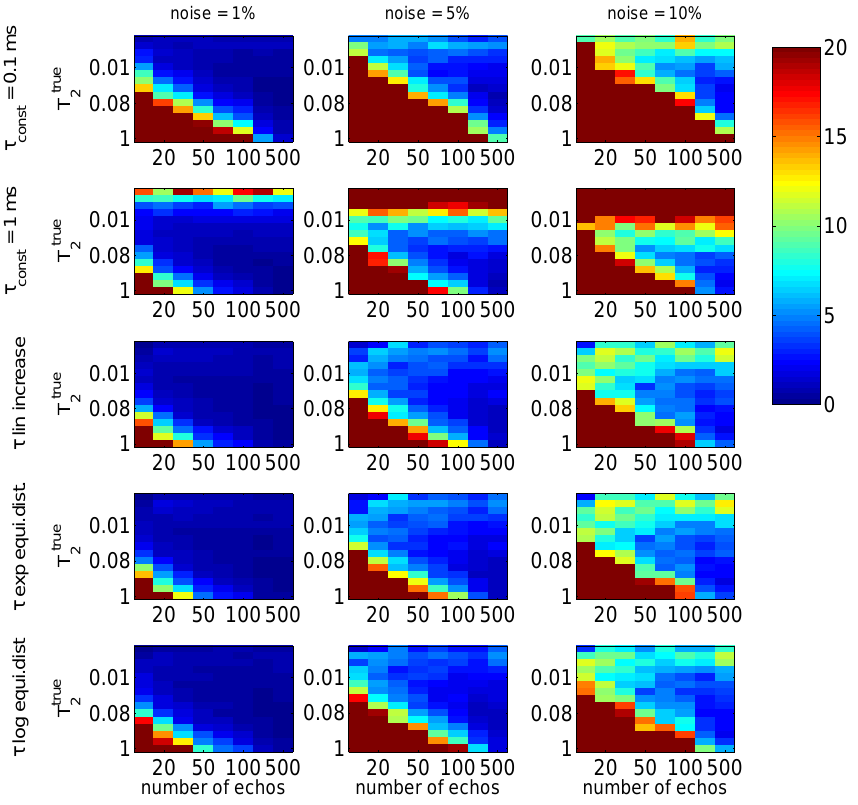
Fig. 3. The evolution of error for different signal-to-noise ratio. Standard deviations between the true transverse decay time T true estimated T 2 depending on the number of echos for mono-exponential synthetic data is shown. All errors over 20% are red